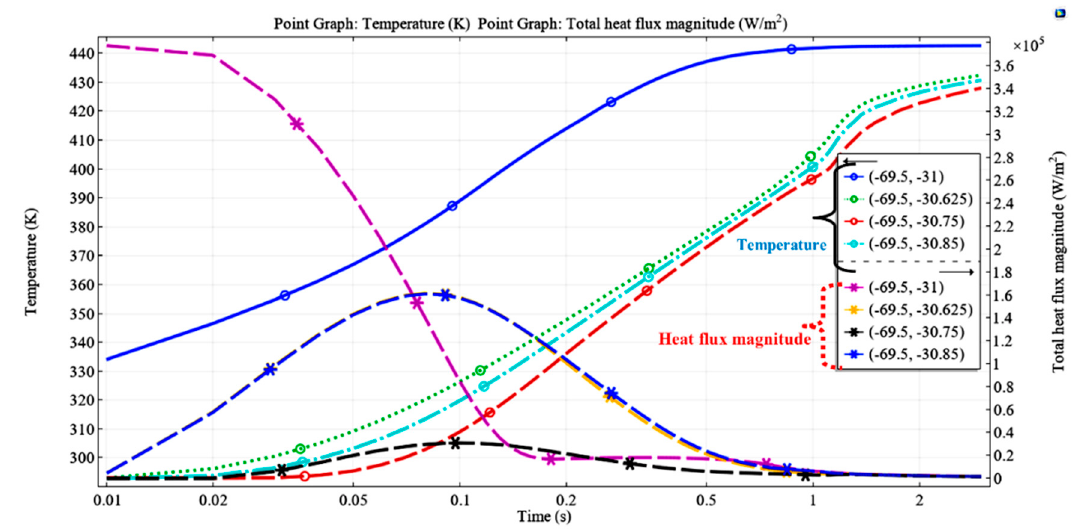
Figure 8. Heat flux with constant temperature on channel walls at different points varying with the time.